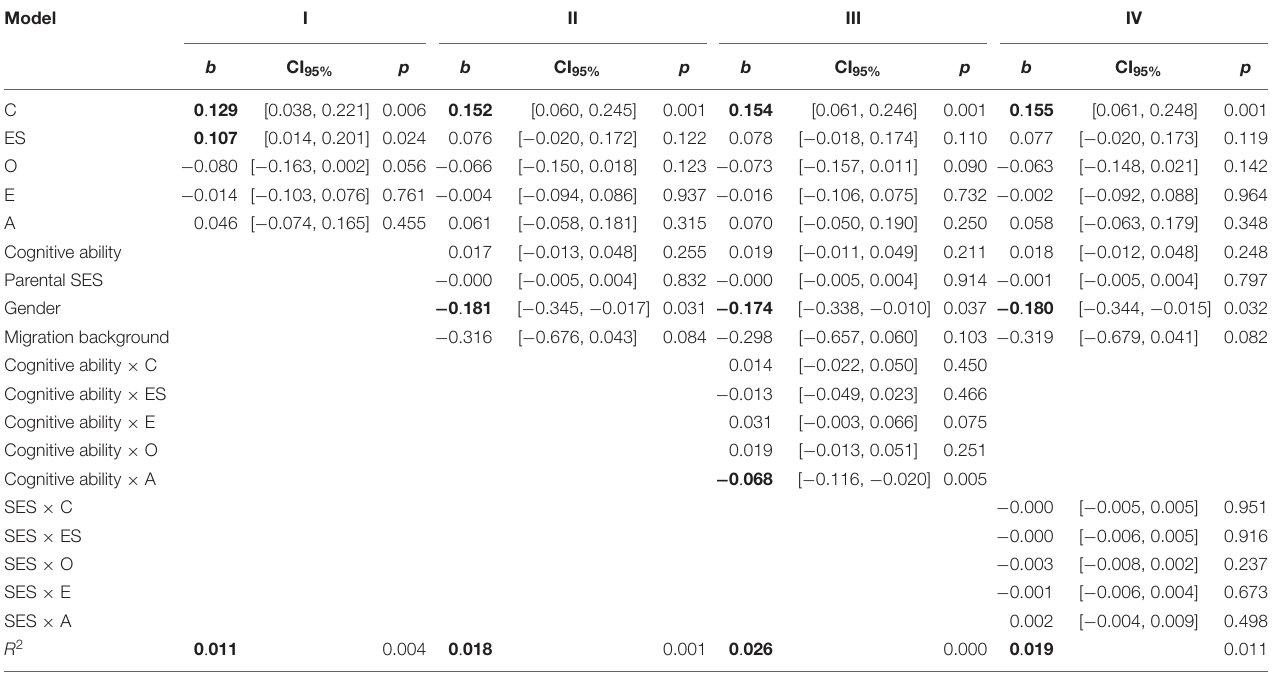
TABLE 9 | Unstandardized regression coefficients for satisfaction with VET after 1 year in a VET position regressed on the Big Five and the covariates.